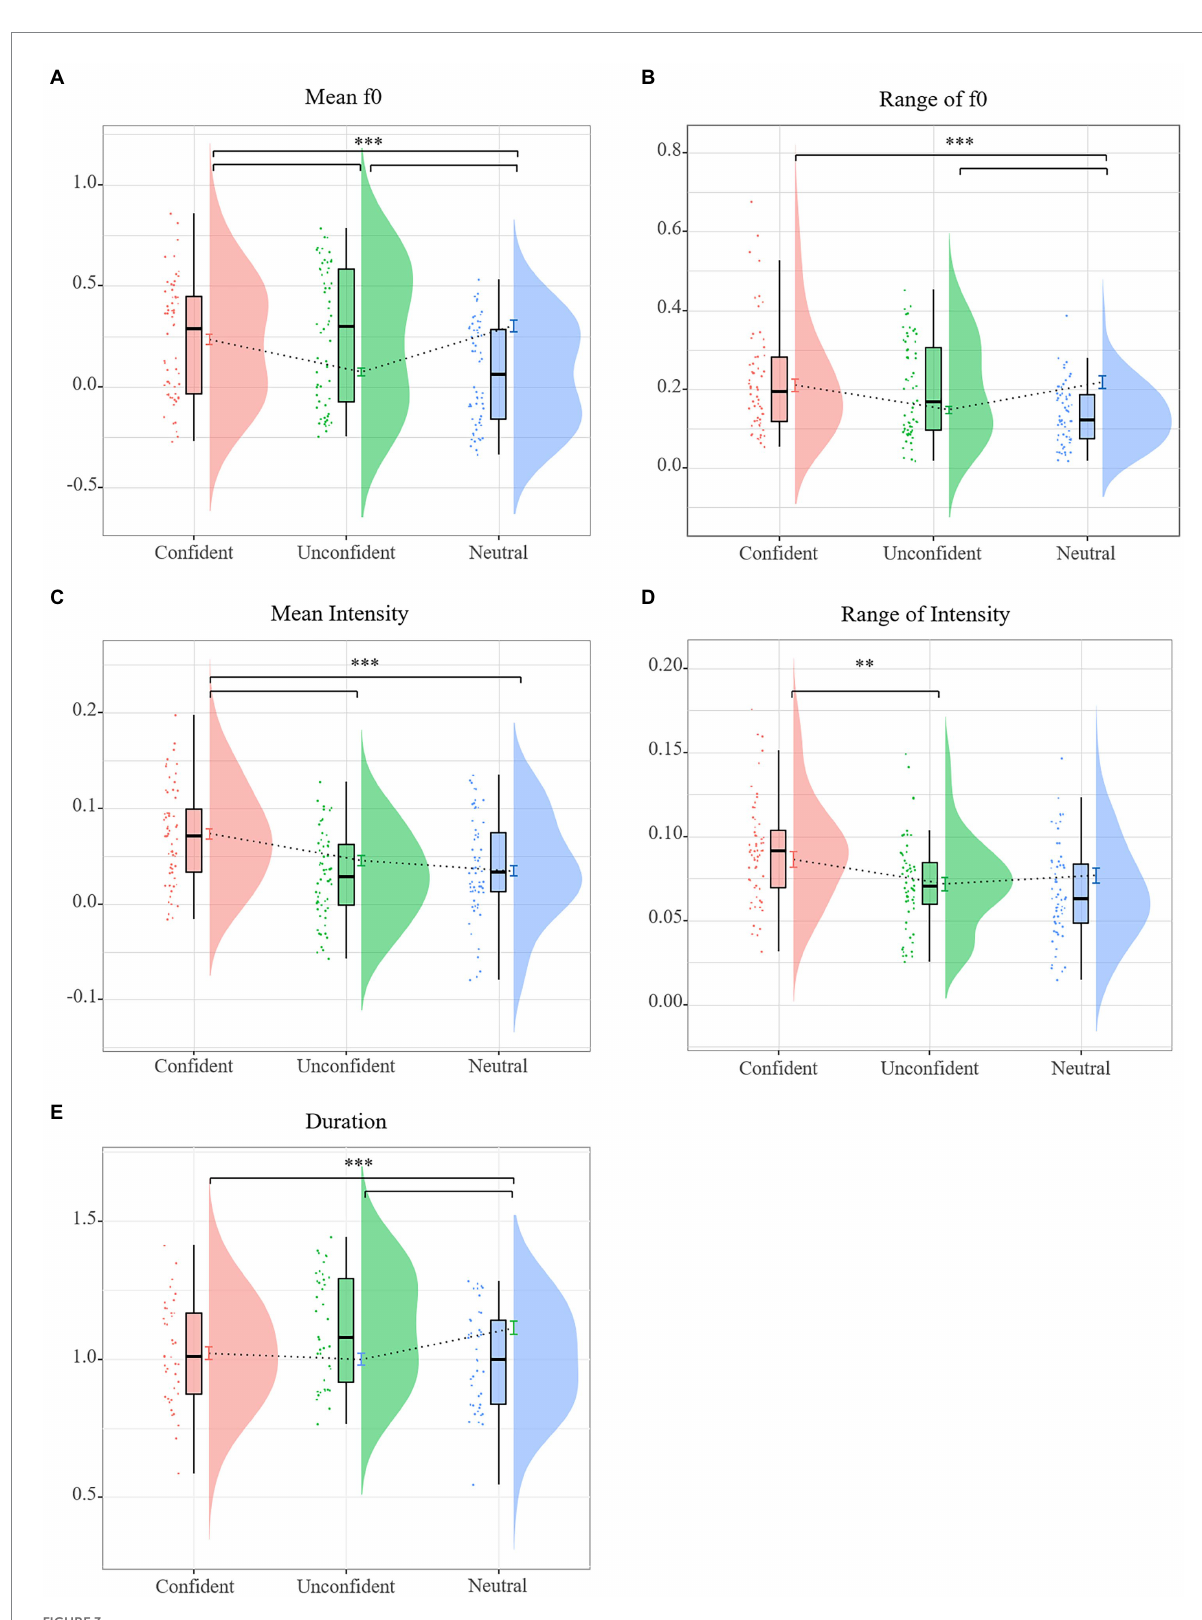
FIGURE 3 Raincloud plots for prosodic features showing the main effect of speaker confidence. (A) mean f0, (B) f0 range, (C) mean intensity, (D) intensity range per confidence level for all vowels, and (E) duration for